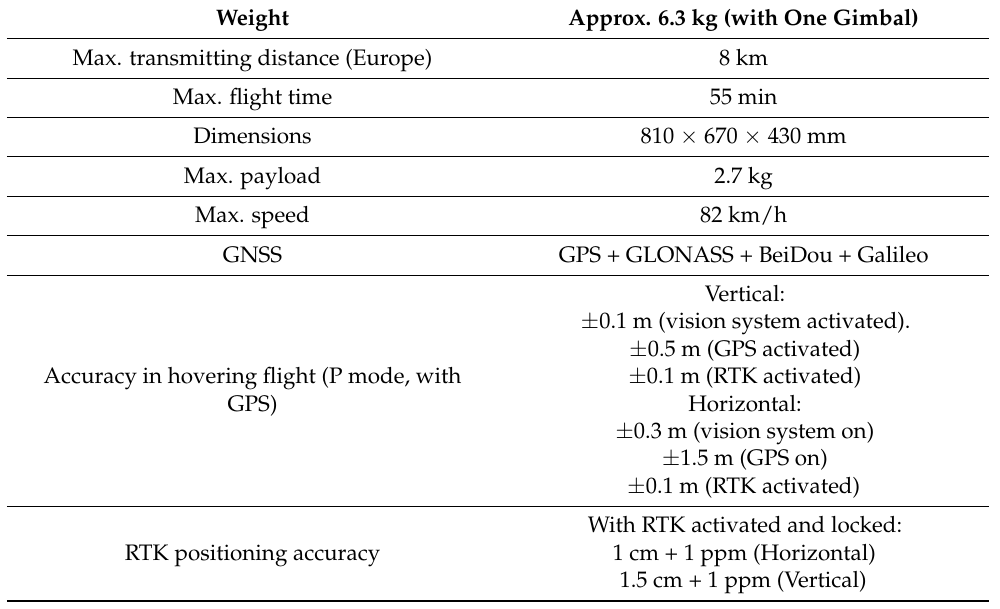
Table 3. Basic characteristics of the UAV DJI Matrice 300 RTK.